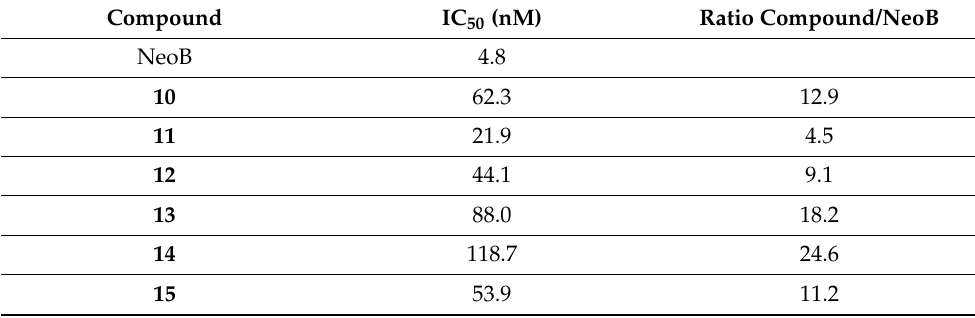
Table 2. IC 50 values of the dual-modality probes, compared to the native NeoB peptide.